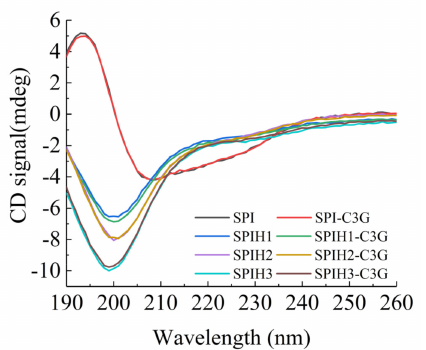
Figure 2. CD spectra of 100 µ g/mL SPI and SPIHs with or without 1 µ g/mL C3G at pH